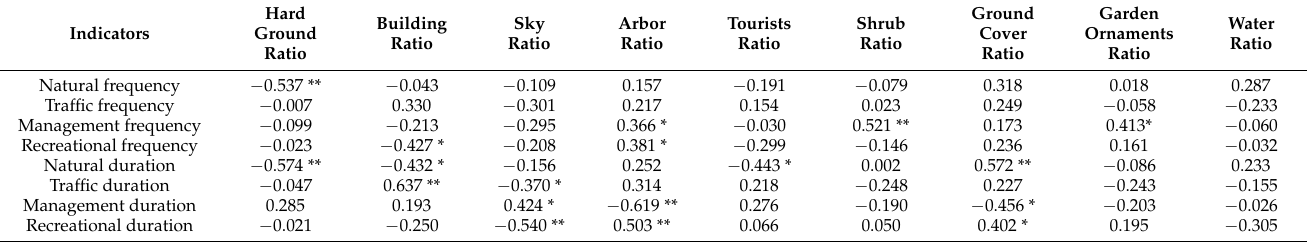
Table 7. Correlation between various sound sources and the proportion of landscape space